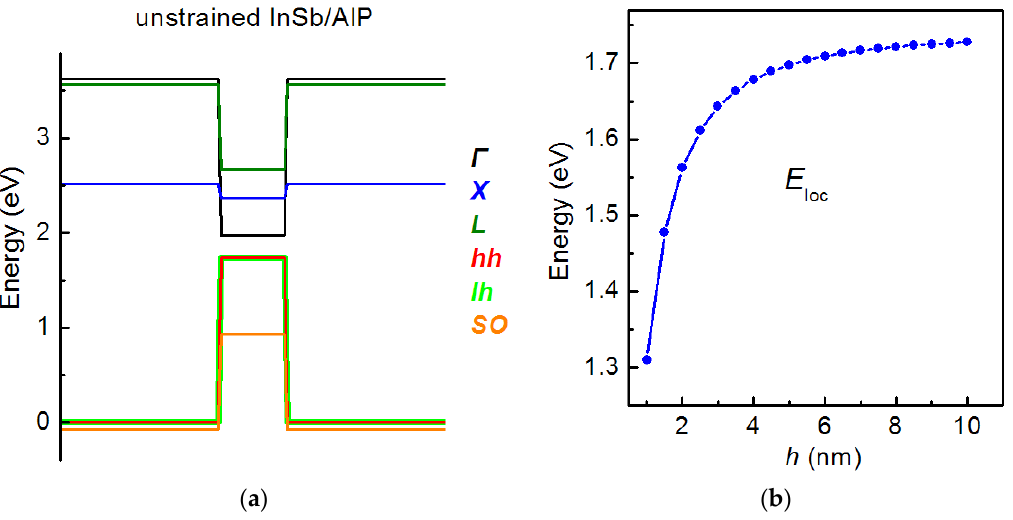
Figure 14. ( a ) Band alignment for the unstrained InSb/AlP SAQD. ( b ) The dependence of E loc on the SAQD height in the unstrained InSb/AlP SAQD.